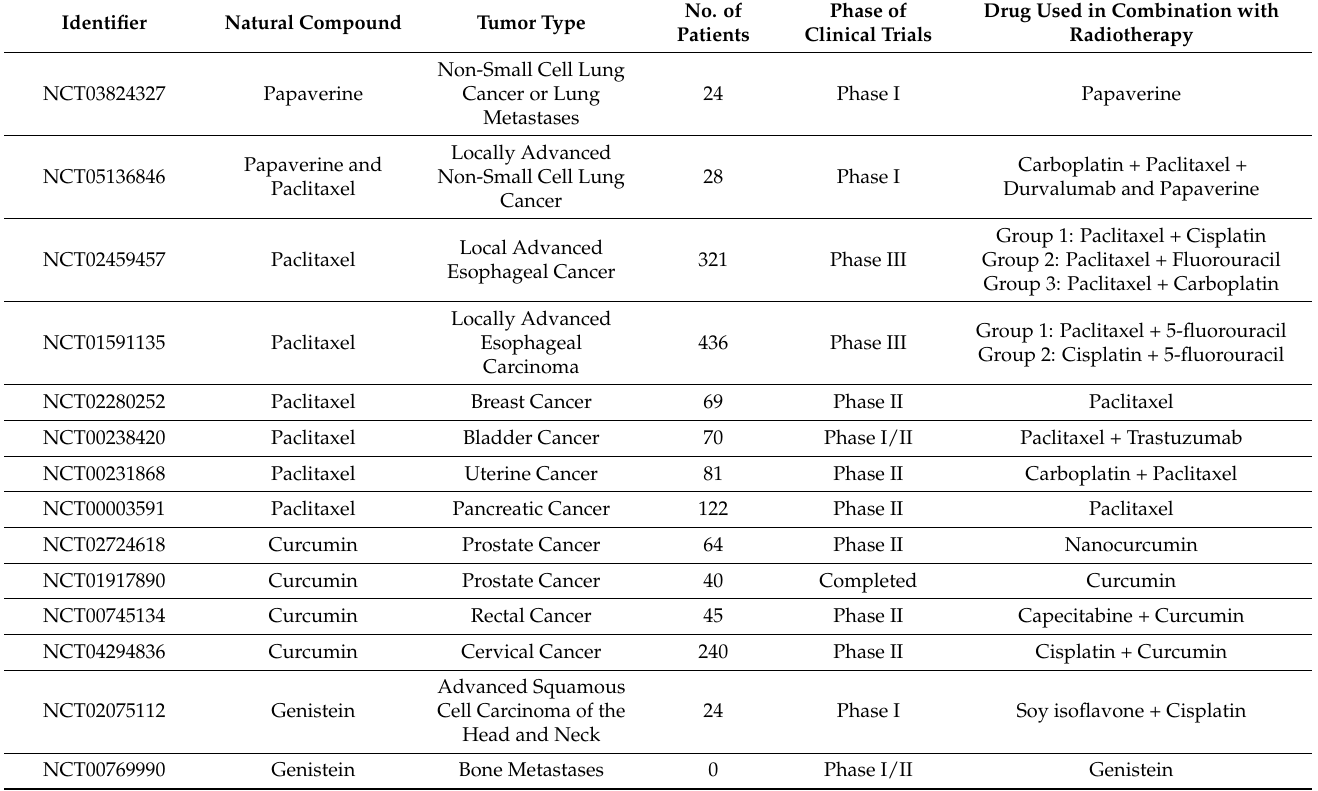
Table 1. Registered Current Clinical Trials of small plant-derived molecules radiosensitizers (https: //Clinicaltrials.gov/, accessed on 4 August